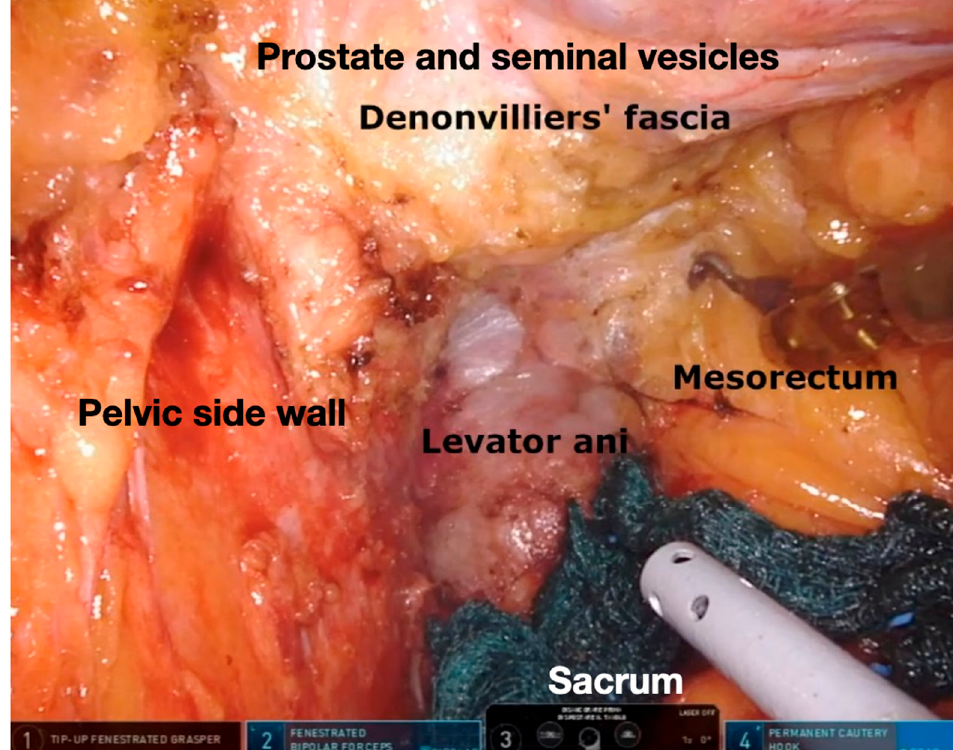
Figure 4. Final view after Total Mesorectal Excision.